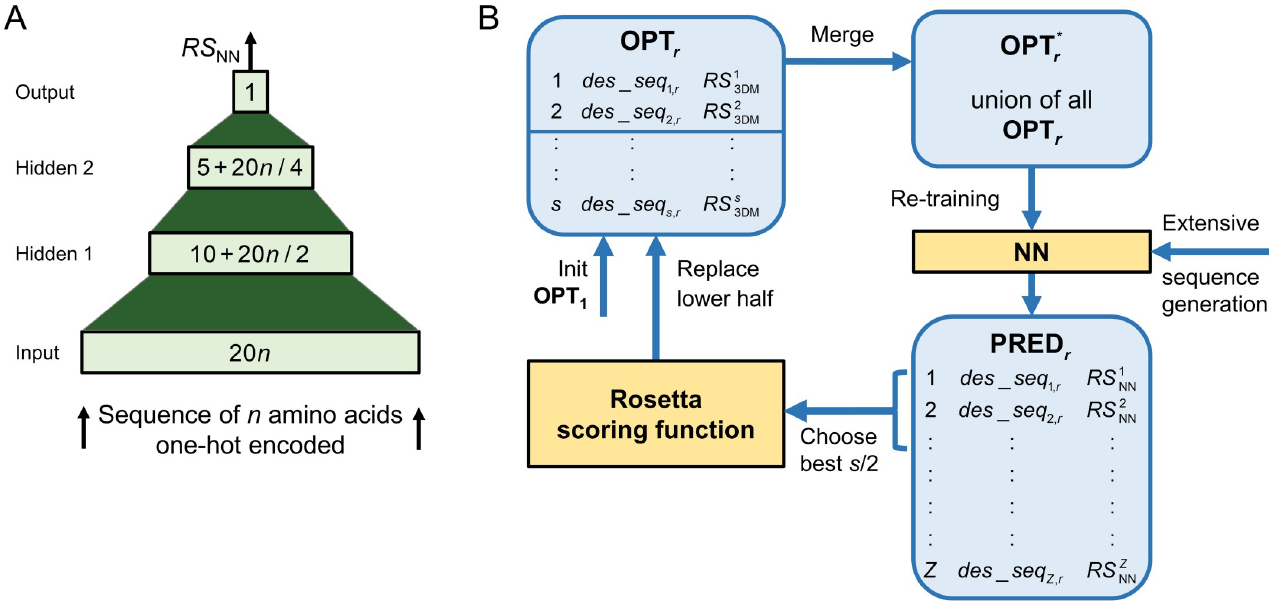
Fig 1. NN architecture and data generation within Rosetta:MSF:NN. (A) The input layer of the NN contains 20 n neurons that process the 20-dimensional vectors representing the amino acids aa j of the pos = 1, ... , n design shell residues under study. The output layer consists of one neuron that determines the pos RS NN value. The first hidden layer consists of 10+20 n /2 neurons and the second hidden layer of 5+20 n /4 neurons. All neurons of adjacent layers are fully connected. (B) During all iterations r of sequence optimization, Rosetta:MSF:NN administers a pool OPT of s sequences, whose RS 3DM values are known. The r union OPT � of these sequences is growing iteration-wise and used to re-train the NN that has an architecture as in (A). The re-trained NN is utilized for an r extensive sequence scan that computes per default the RS NN values for Z = 2,000,000 randomly generated sequences based on a seed. For s /2 sequences possessing highest RS NN values, the (costly) RS 3DM is computed. These sequences and their RS 3DM values constitute the lower half of the updated set OPT r +1 . For the first iteration, OPT 1 is initialized with s